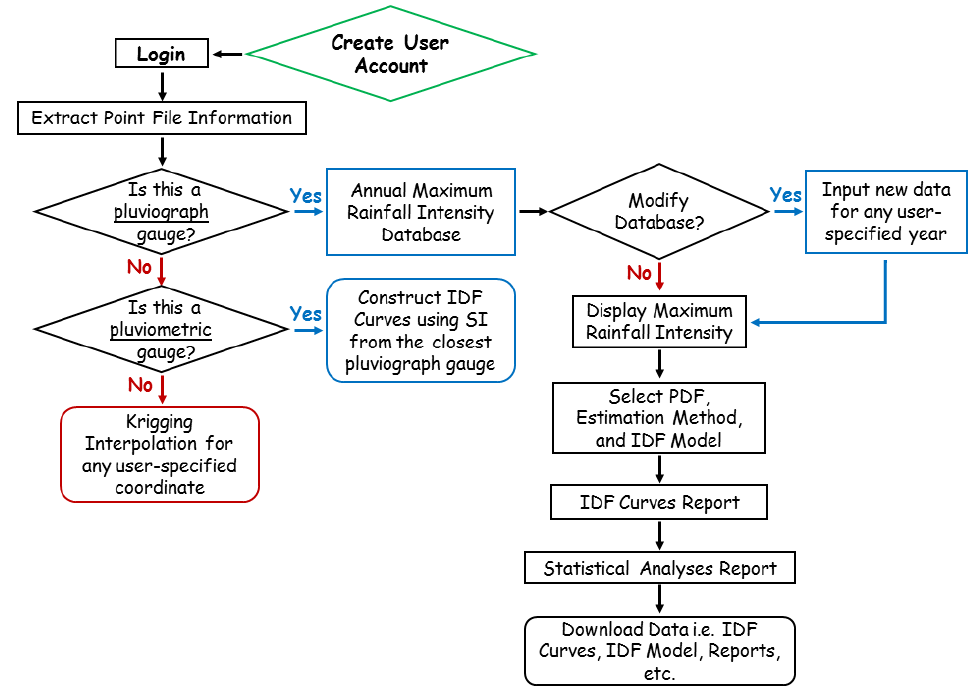
Figure 5. Flow diagram showing the general procedure to generate IDF Curves in WEBSE IDF . S I —storm index; PDF—probability distribution function.